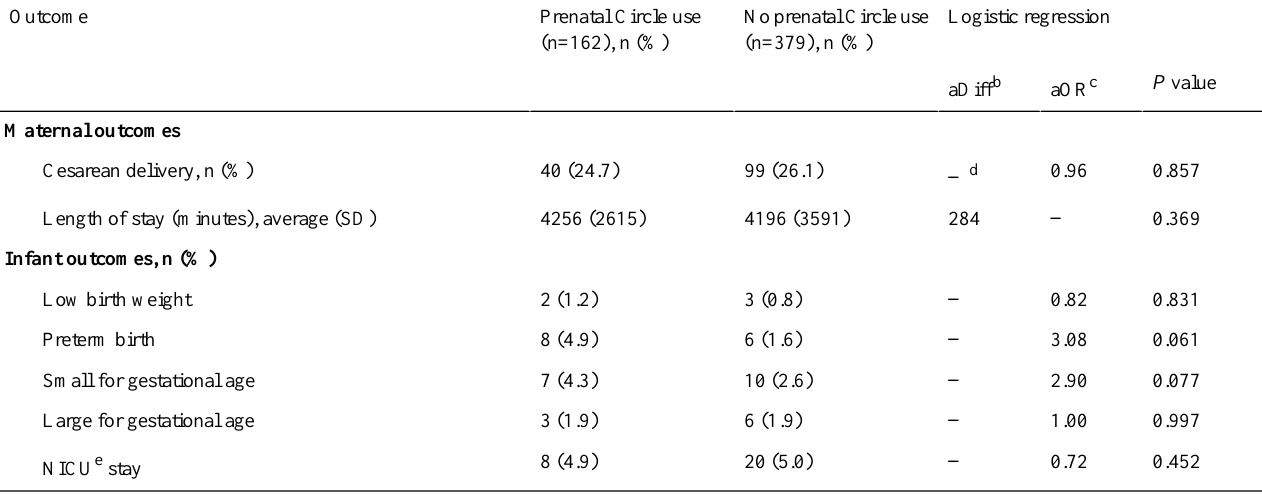
Table 5. Clinical outcomes for birth parent and infant (n=541 a ). Italicized P values are significant.